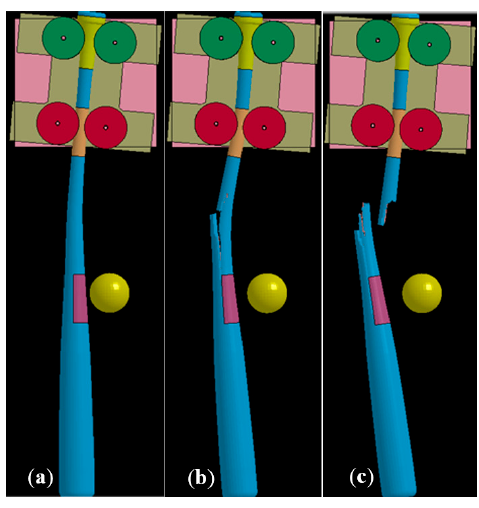
Figure 12. Bat model failure modes at varying impact velocities; ( a ) No failure at 120 mph (193 kph), ( b ) Single-piece failure at 130 mph (209 kph) and ( c ) Multi-piece failure at 145 mph (233 kph).